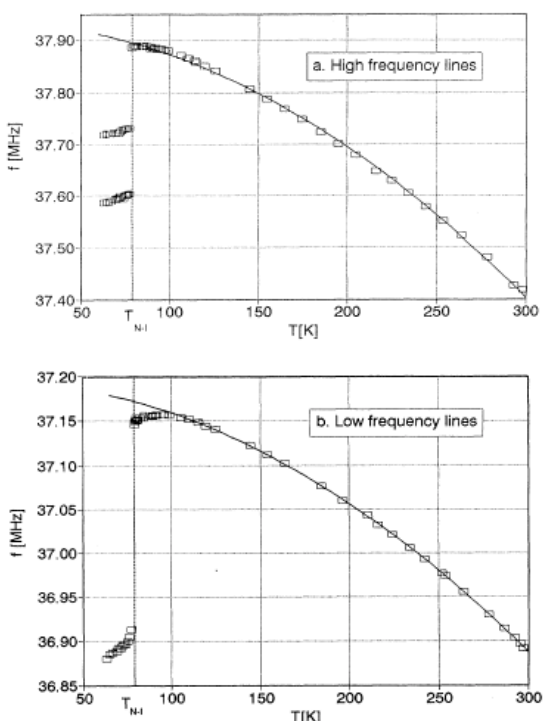
Figure 4. Temperature dependence of the high-( a ) and low-( b ) frequency chlorine NQR lines in TTF-CA. From Reference [24,25] with permission. Copyright 1993 American Physical Society.